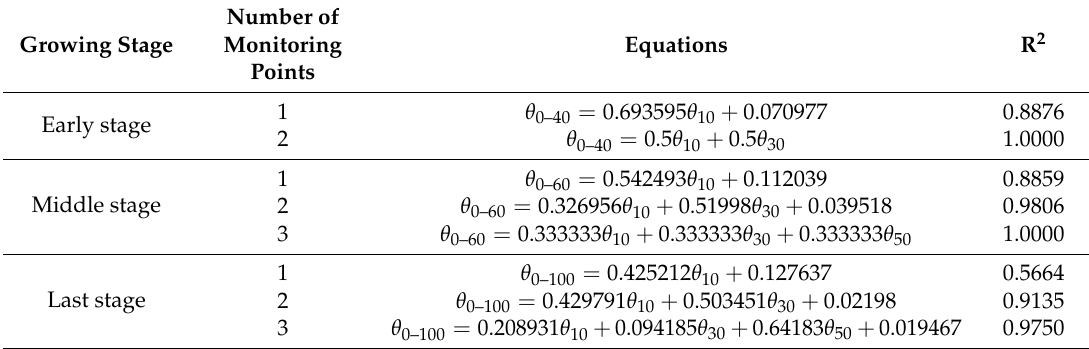
Table 5. Regression equations for calculating soil moisture content in soil wetting layers based on the observed data of soil moisture with proper positioning of soil moisture